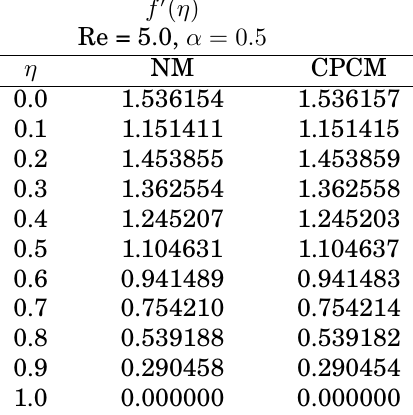
Table 2: Comparison of the results regarding the flow for small Reynolds number for injection and expansion.